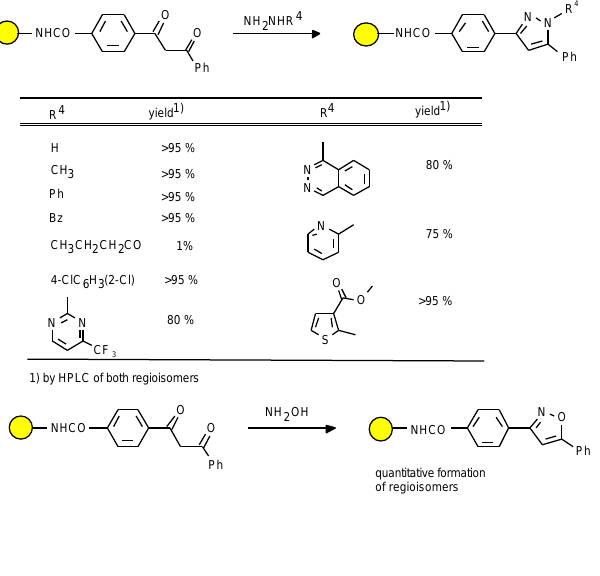
Table 5 . Formation of pyrazoles 4e-n (R 1 = 4-Ph, R 2 = Ph, R 3 =